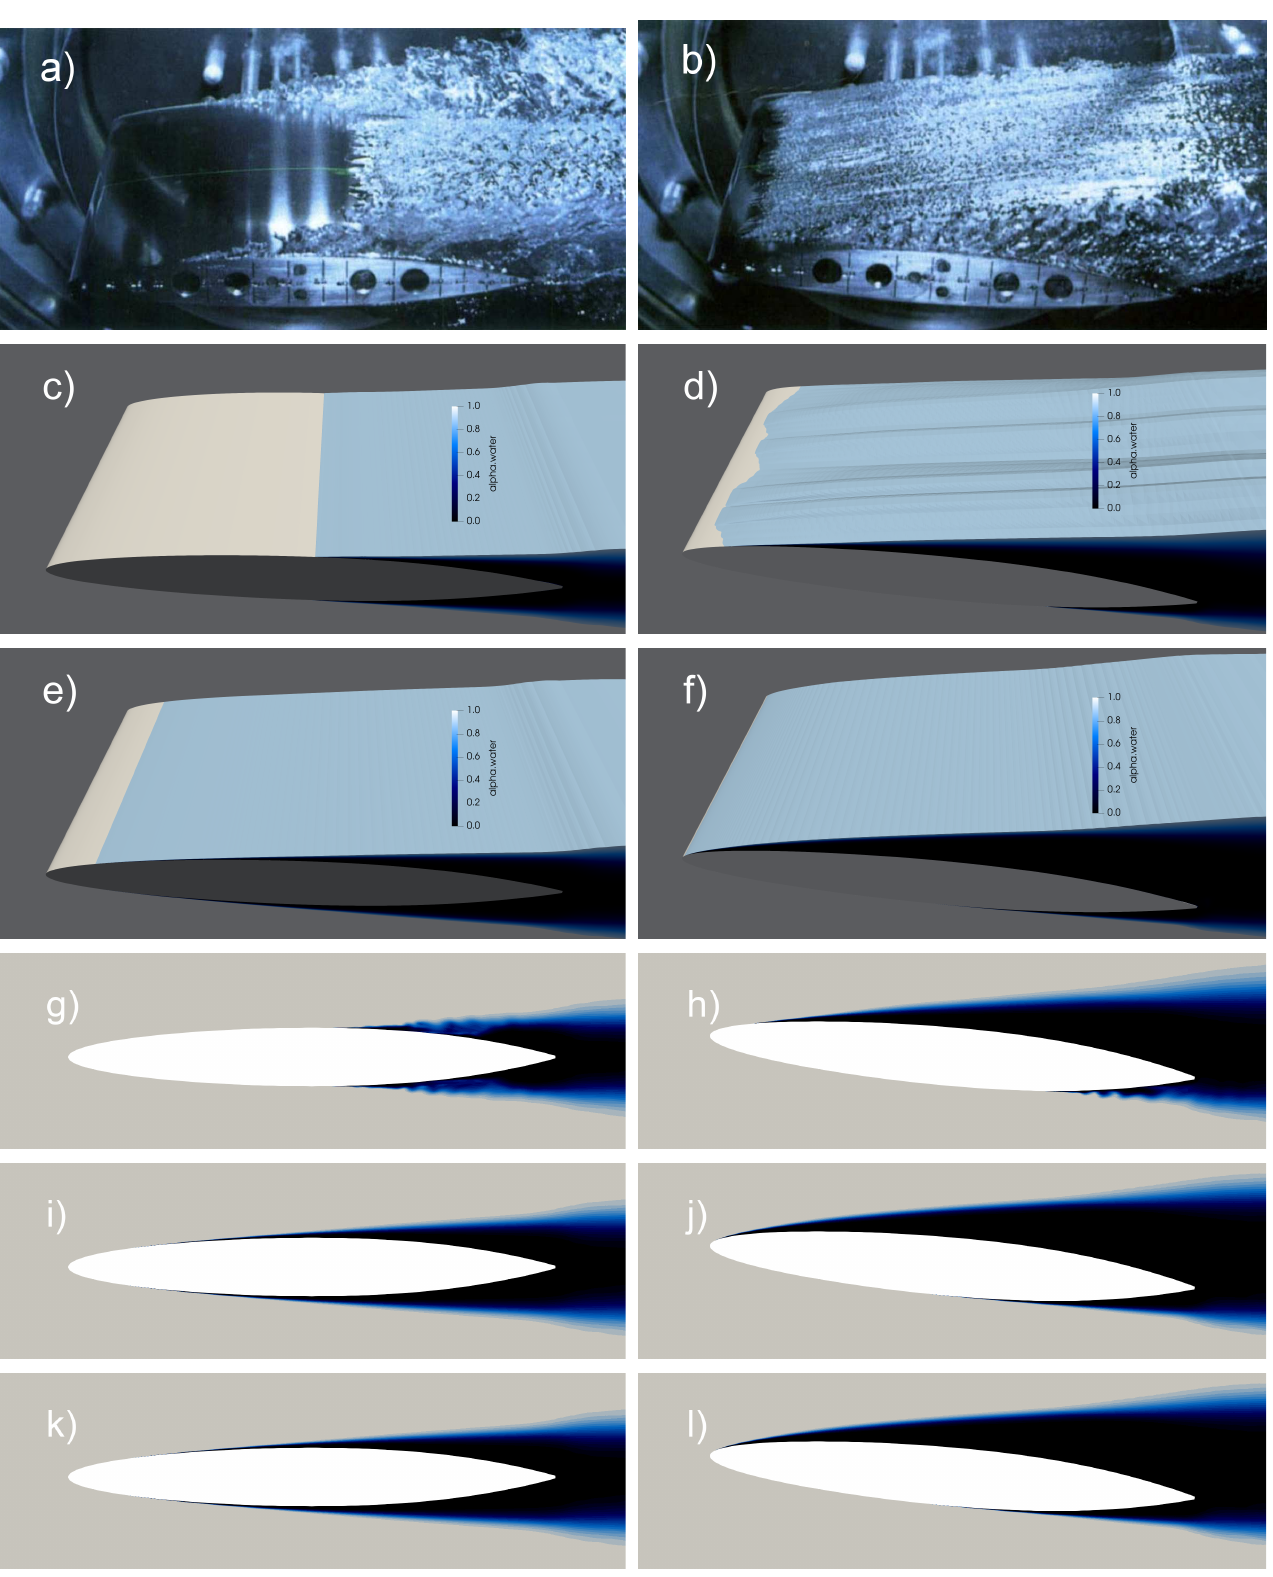
Figure 11. Cavitation patterns on NACA 16012 at AoA of 3 ◦ (left column) and 5 ◦ (right column) with Re = 1,000,000; σ = 0.045. From top to bottom: ( a , b ) experimental photos; ( c , d ) bridged model, 3D; ( e , f ) k − ω SST + SS , 3D; ( g , h ) bridged model, 2D; ( i , j ) k − ω SST + SS , 2D; ( k , l ) γ − Re θ + SS ,